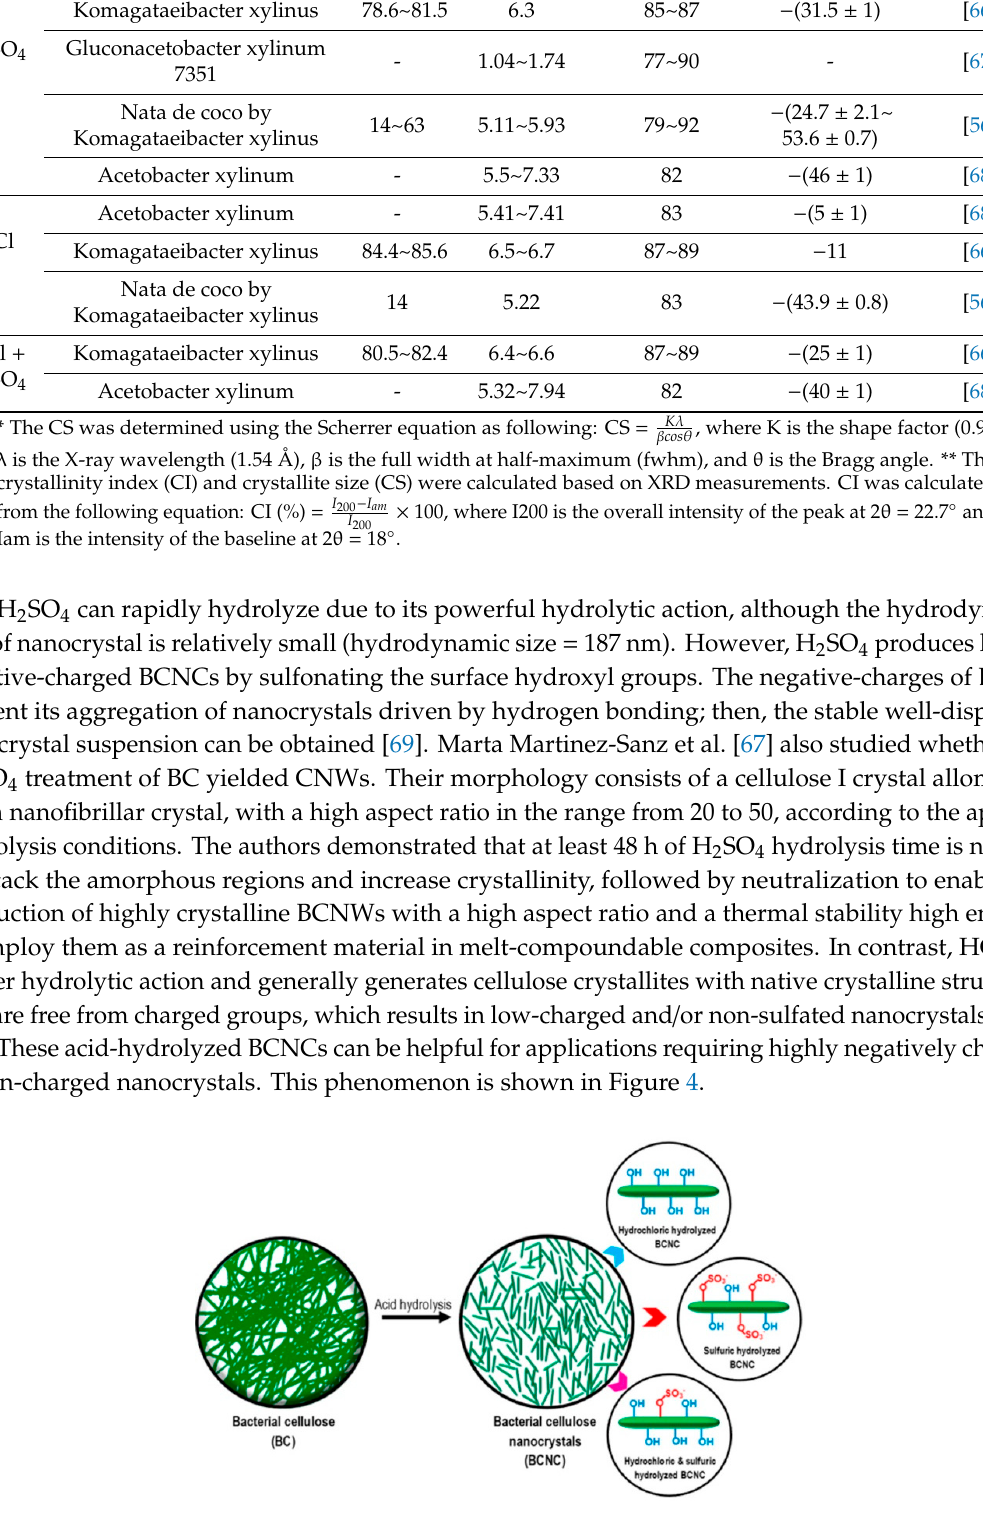
Table 2. The properties of BCNCs from acid hydrolysis. Acid type